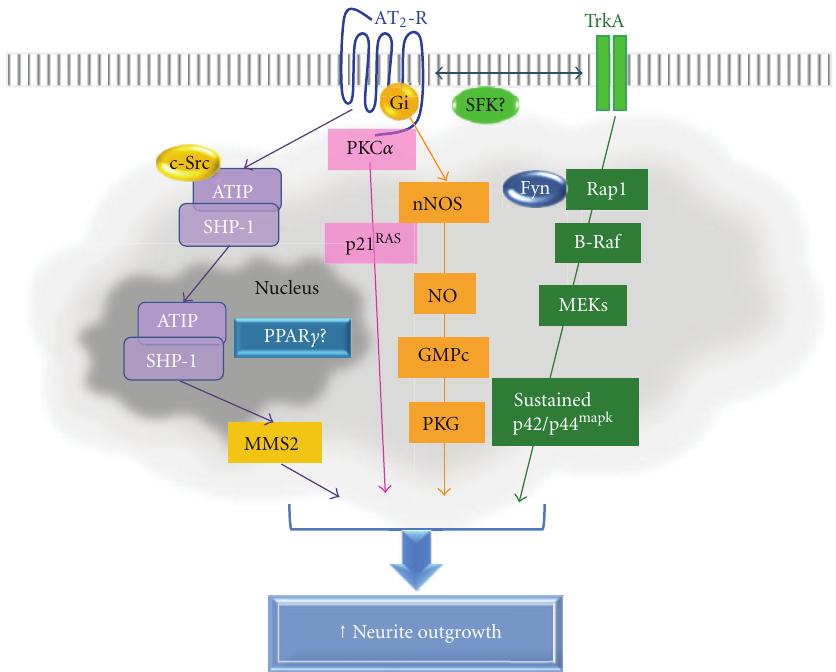
Figure 2: Overview of the main signaling pathways implicated in the action of AT 2 receptor leading to neurite